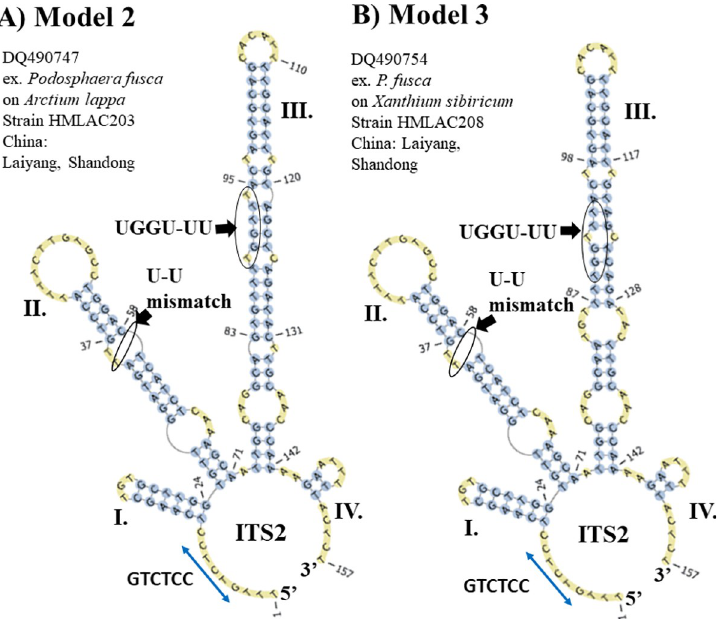
Fig 6. The second most common ITS2 S2 (Model 2) found in the Ampelomyces population. (A) The ITS2 S2 Model 2 derived from mycoparasites extracted from the three PM genera Arthrocladiella , Golovinomyces and Podosphaera . (B) The ITS2 S2 Model 3 was only found in one ITS2 sequence (GenBank accession number DQ490754) from Ampelomyces sp. extracted from P . fusca . The helices are indicated by Roman numerals (I–IV). Single-stranded rings (between helices I and IV) for Models 2 and 3 with the sequence GTGTCC are indicated with blue left right arrows. The following shared ITS2 features are indicated by black arrows and circles: (1) a U-U mismatch on helix II and (2) the UGGU and UU motifs on helix III. The structures were directly folded and modelled with the ITS2-DB.